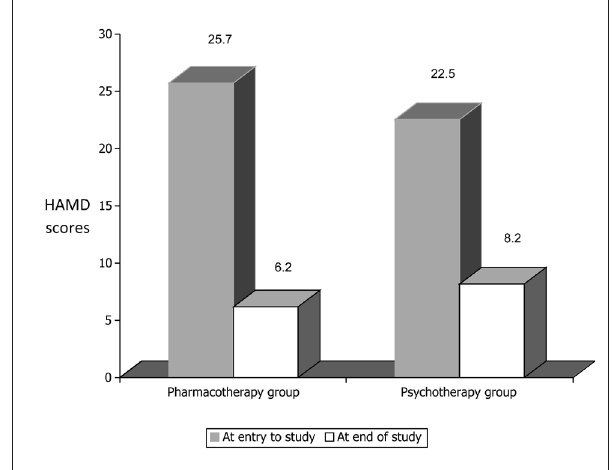
Fig. 1. Changes in HAMD scores in the two treatment groups from baseline to end of